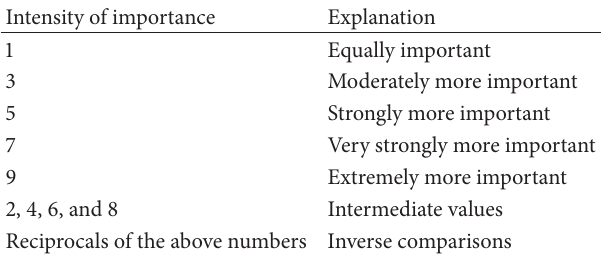
Table 1: Value of judgment matrix.